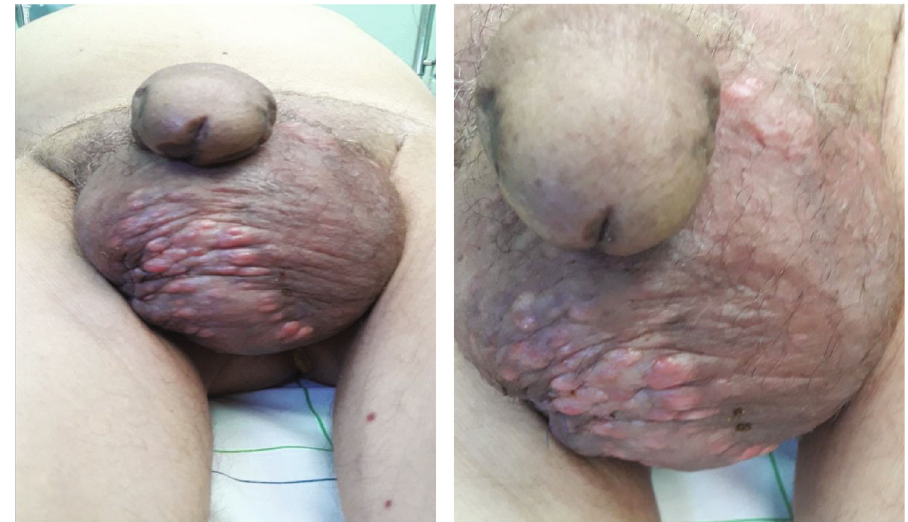
Figure 1: Clinical image of scrotal lesions palpable, fi rm, soft, and mobile subcutaneous nodules.